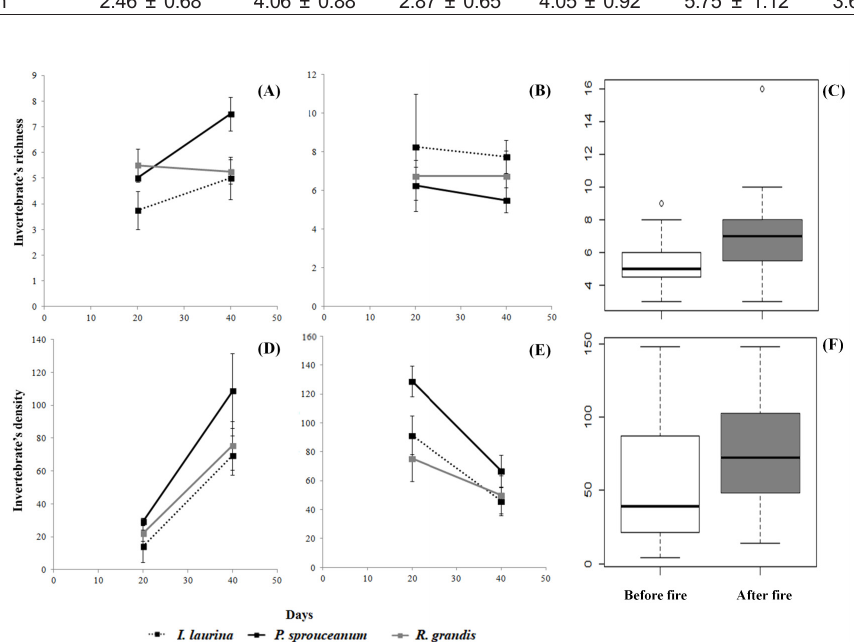
Figure 3. Invertebrate richness (A, B and C) and density (D, E and F) among different leaf litter (A, B, D and E) before (A, C and white in C and F) and after fire (B, D and gray in C and F) in a stream in a ecotone between Savannah and Tropical Rain Forrest.